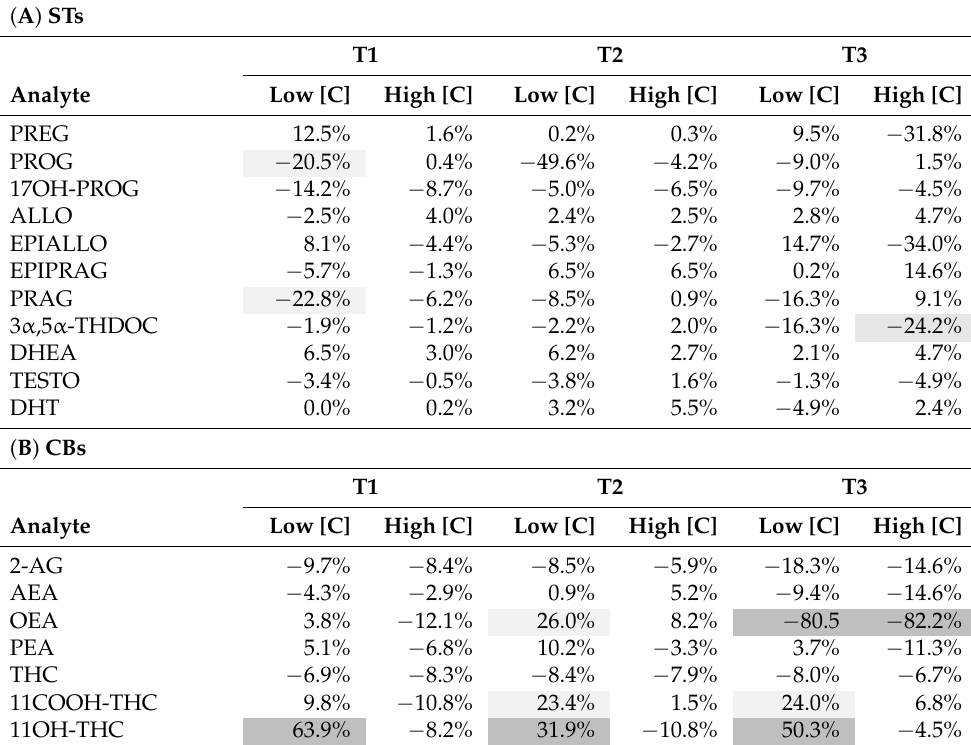
Table 5. Post-preparative stability for steroids (STs) ( A ) and cannabinoids (CBs) ( B ) at the auto- sampler temperature expressed as mean% difference (n = 3) from T0 (T1: 12 h delay; T2: 24 h